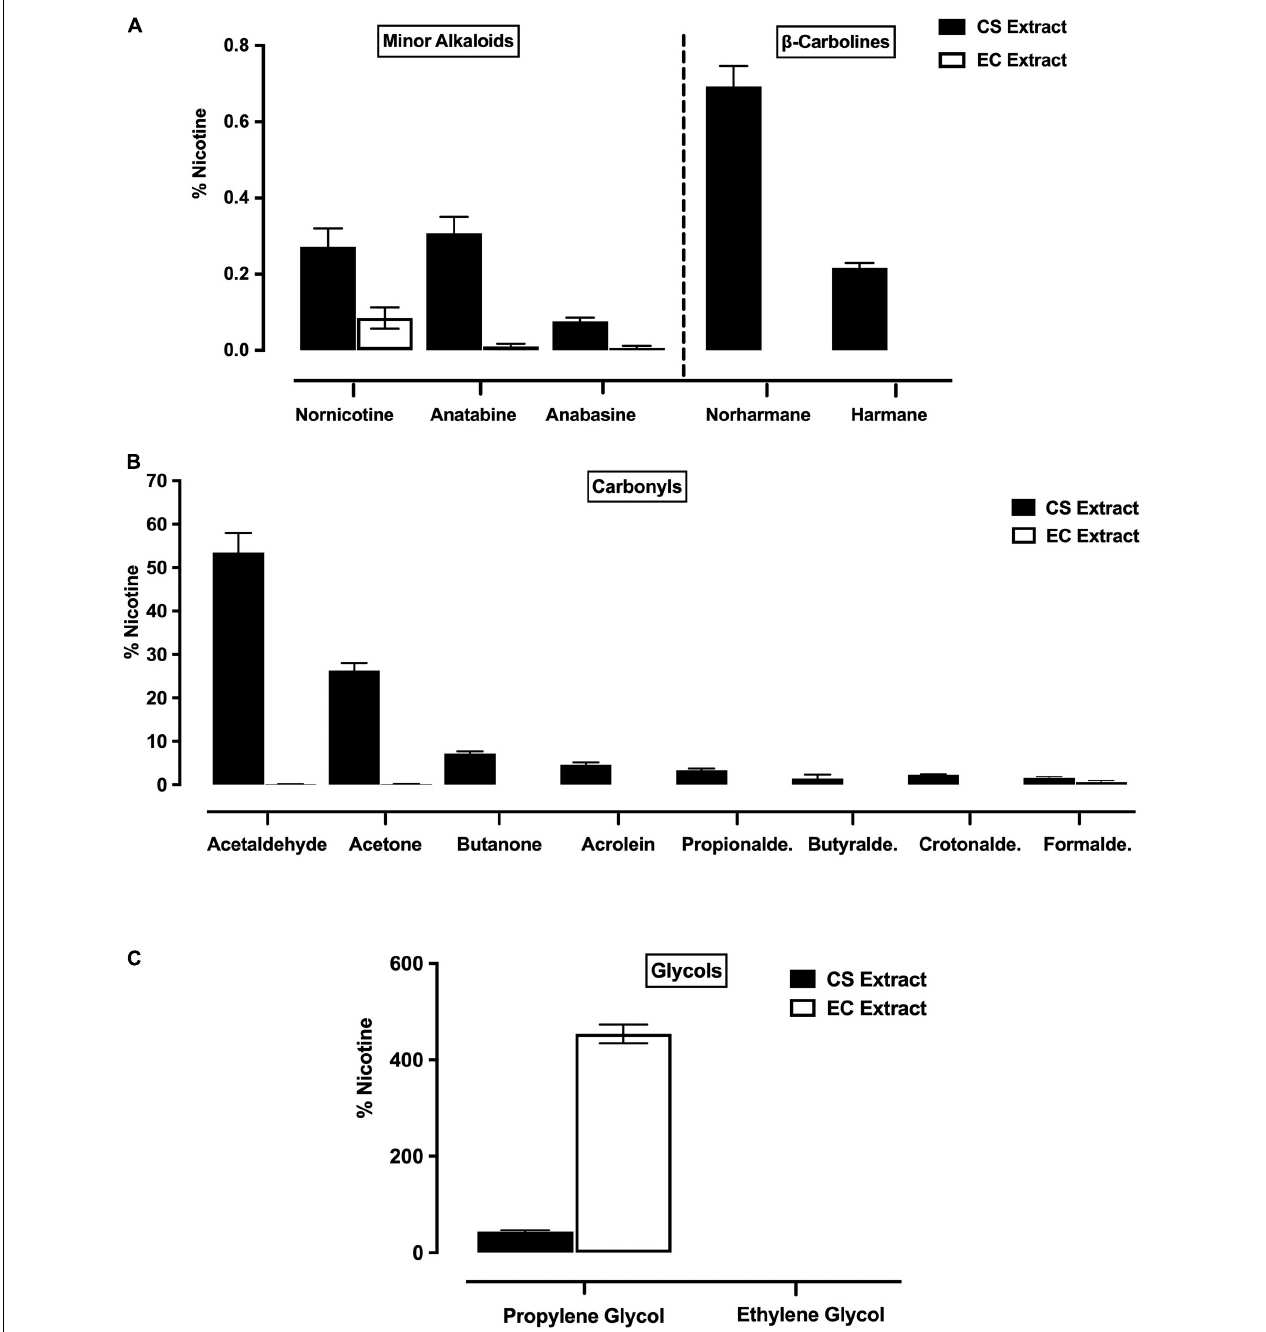
FIGURE 1 | Levels (expressed as % of nicotine, mean ± SEM) of minor alkaloids ( A , left panel), β -carbolines ( A , right panel), carbonyls (B) and glycols (C) in CS extract and EC extract. Minor alkaloids and carbonyls were measured in all eight representative batches of CS and EC extract, whereas β -carbolines and glycols were measured in three of these